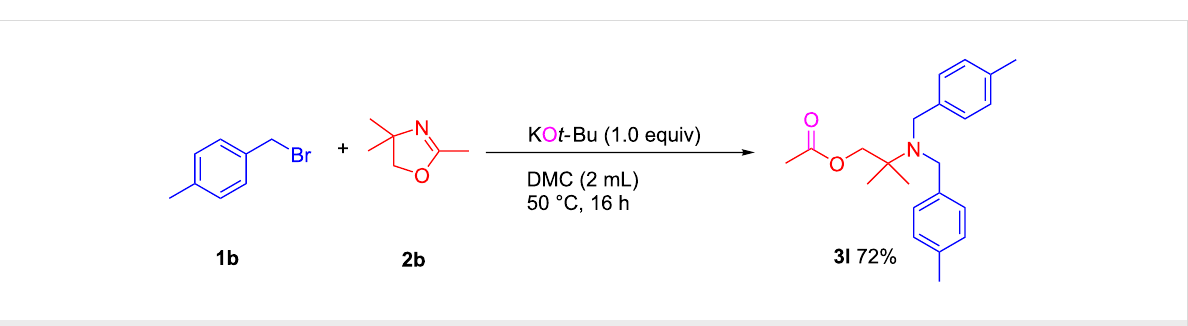
Scheme 4: KO t -Bu-promoted selective ring-opening N -alkylation of 2,4,4-trimethyl-4,5-dihydrooxazole ( 2b ) with 4-methylbenzyl bromide ( 1b